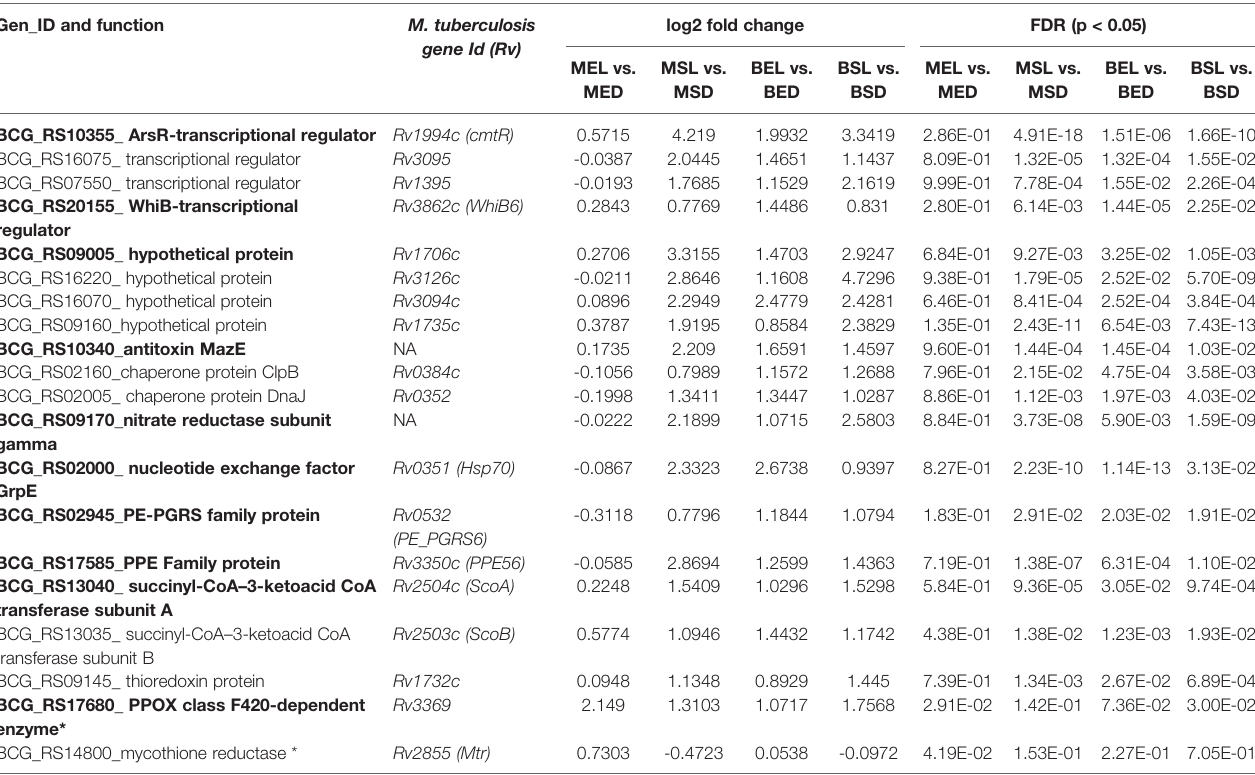
TABLE 1 | Log2 Fold-Change and p-values of M. bovis BCG lipid signature genes. Gen_ID and function M. tuberculosis